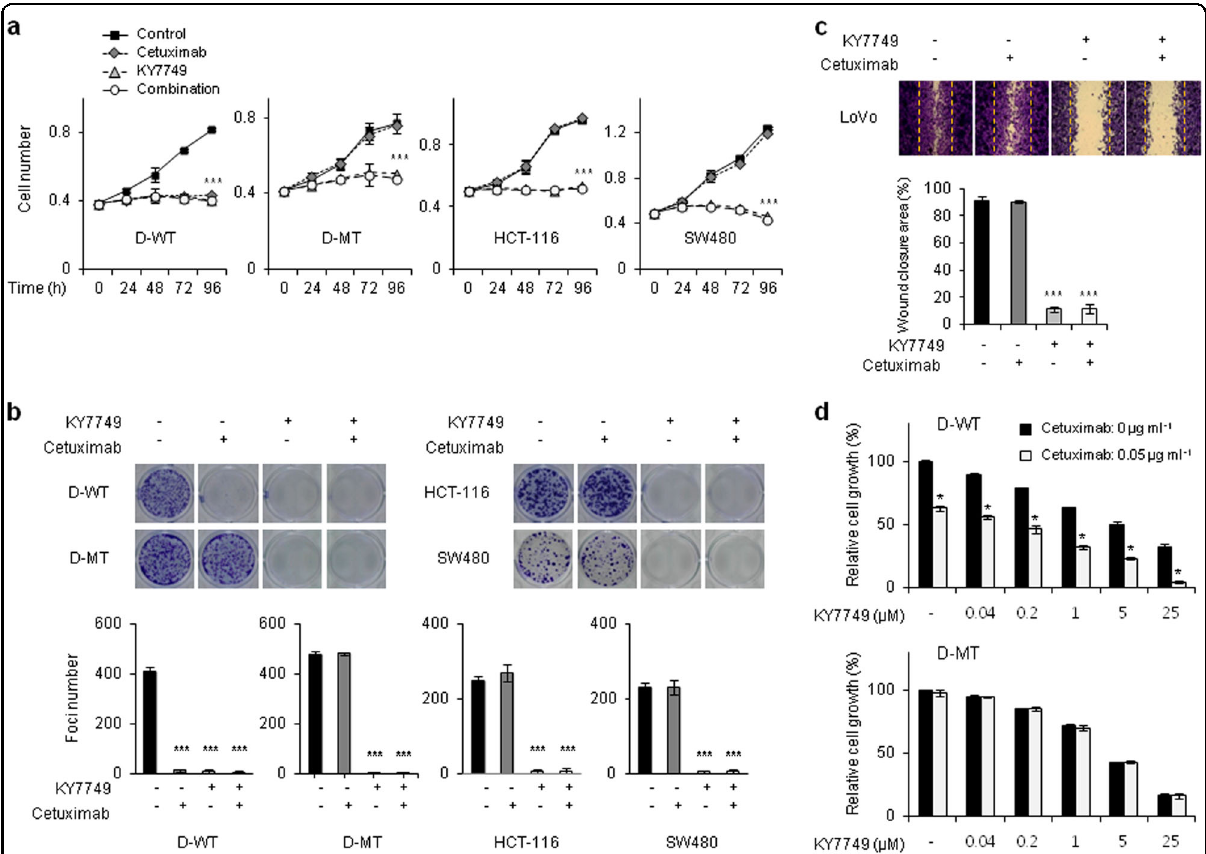
Fig. 5 The effects of KY7749 or cetuximab on growth, transformation, and migration of CRC cells. a MTT assays in D-WT, D-MT, HCT-116, and SW480 cells cultured with DMSO, 25 μ M KY7749, 5 μ g ml − 1 cetuximab, or KY7749 and cetuximab together for the indicated time periods (mean ± SD, n = 3). b Colony formation assays in D-WT, D-MT, HCT-116, and SW480 cells cultured with 25 μ M KY7749, 5 μ g ml − 1 cetuximab, or KY7749 and cetuximab together for 13 – 18 days (mean± SD, n = 3). c Migration assays of LoVo cells cultured with 25 μ M KY7749, 5 μ g ml − 1 cetuximab, or KY7749 and cetuximab together for 18 h (mean± SD, n = 3). Images were captured by bright fi eld microscopy at 18 h (upper panel) to quantify the wound closure area (lower panel). d MTT assays in D-WT and D-MT cells co-treated with the indicated doses (0.04 to 25 μ M) of KY7749 and 0.05 μ g ml − 1 cetuximab for 96 h (mean ± SD, n =